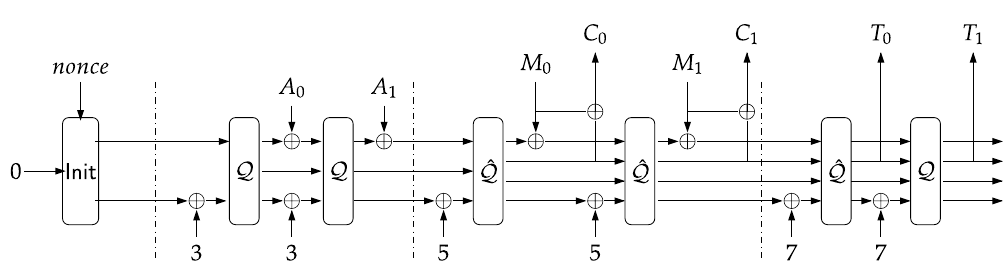
Figure 1. TinyJAMBU ’s mode of operation (encryption